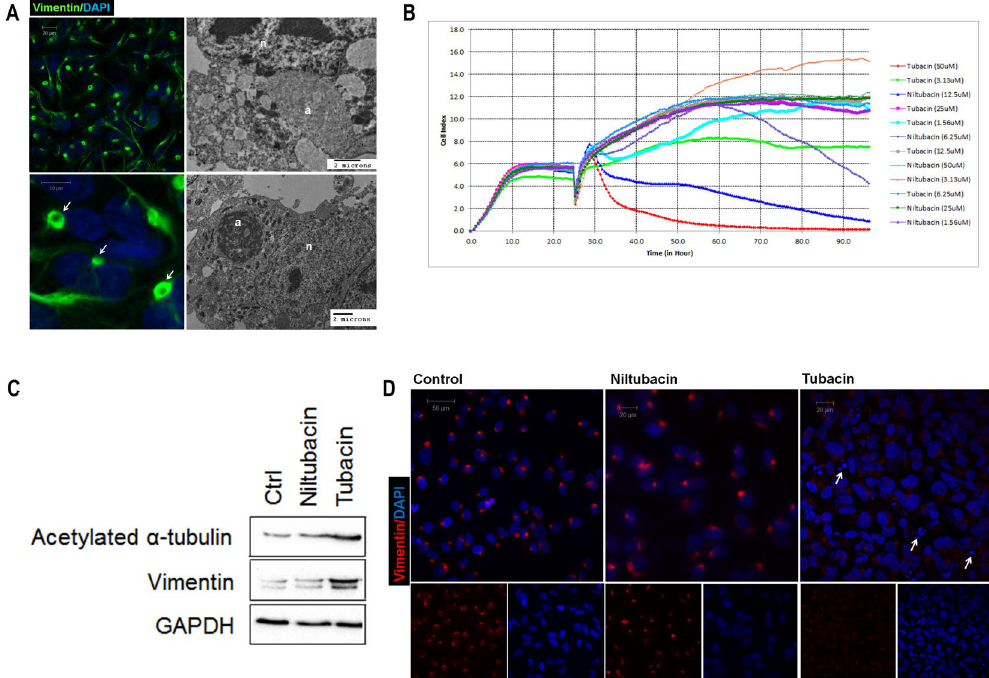
Figure 1. Constitutive formation of aggresomes in choroid plexus carcinoma tumor cell line CCHE-45. ( A ) Aggresomes subcellular localization was identified by the formation of vimentin cage (white arrows). CCHE-45 cells were fixed and immunostained with rabbit anti-vimentin and visualized using Alexa Flour 488 anti-rabbit IgG antibody. Cells were counterstained with DAPI to visualize the nucleus. TEM examination of CCHE-45 cell line showing aggresomes ultra structures. ( B ) The effect of tubacin and niltubacin on CCHE-45 cell line was evaluated using xCELLigence system. Cells were treated with different concentration of tubacin or niltubacin and dynamically monitored for 72 hours. Cell index was used to assess changes in cell growth under different concentrations of tubacin or niltubacin. The e xperiment was repeated three times. ( C ) Western blot analysis of CCHE-45 cells treated with tubacin or niltubacin for 24 hours or left untreated (Ctrl). GAPDH was used as a loading control. ( D ) Immunofluorescence analysis of CCHE-45 cells. Cells were treated with niltubacin, tubacin or left untreated (control) for 24 hours. Cells were immunostained with mouse anti-vimentin and counterstained using DAPI. White arrows in CCHE-45 tubacin treated cells indicate fragmented nuclei. a = aggresomes, n = nucleus, Ctrl =